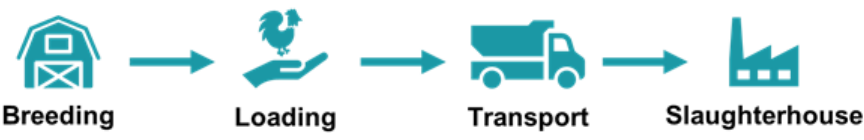
Figure 2. The four phases involved in a poultry production